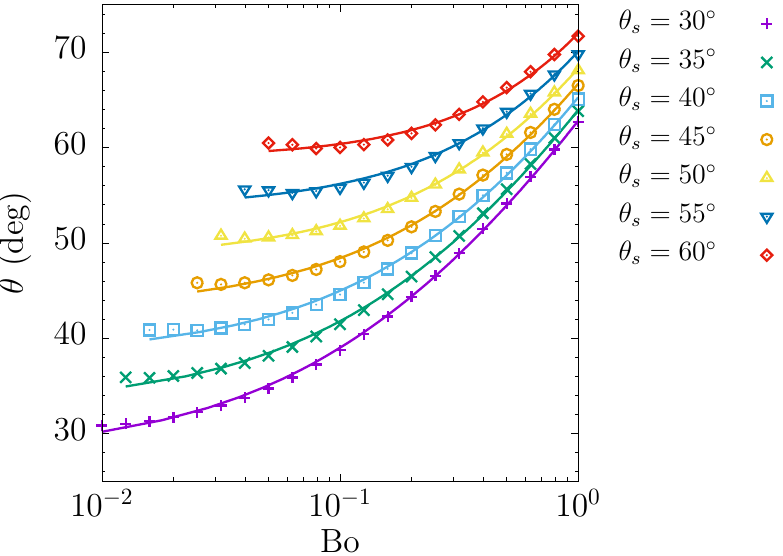
Figure 3. Dynamic contact angle for a stable film as a function of the film Bond number and of the static contact angle: numerical points (markers) vs. Equation (24) (continuous lines). Left-most markers depicts the critical Bond number at different surface wettability, below witch film instability occurs. 1D falling film, α = 60 ◦